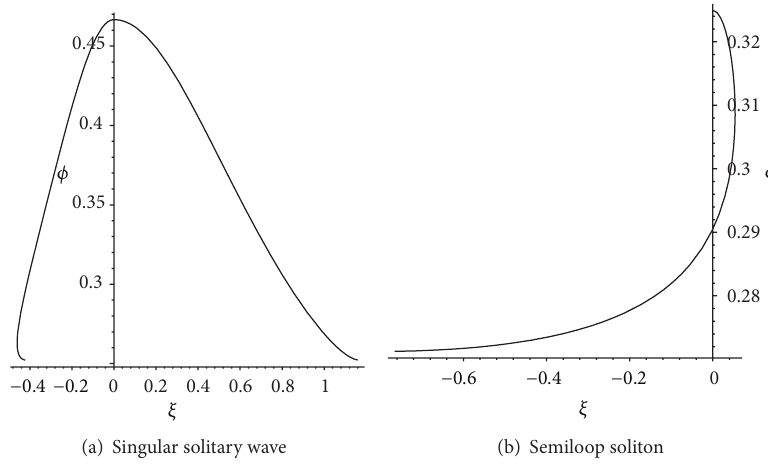
Figure 1: Profiles of solutions (40) and (46) for the fixed